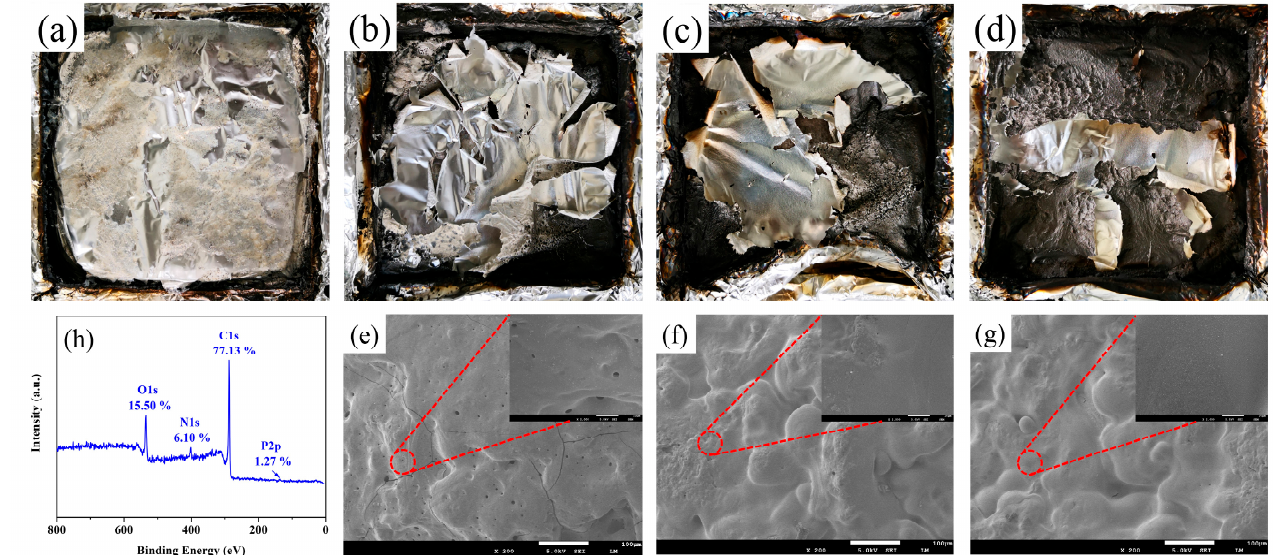
Figure 4. Digital images of the residual char of ( a ) PLA0, ( b ) PLA2.5, ( c ) PLA3.0, and ( d ) PLA3.5 after CCT; SEM images (200× and 2000×) of the residual char of ( e ) PLA2.5, ( f ) PLA3.0, and ( g ) PLA3.5 after CCT; ( h ) XPS analysis of char residues of PLA3.0 after CCT.